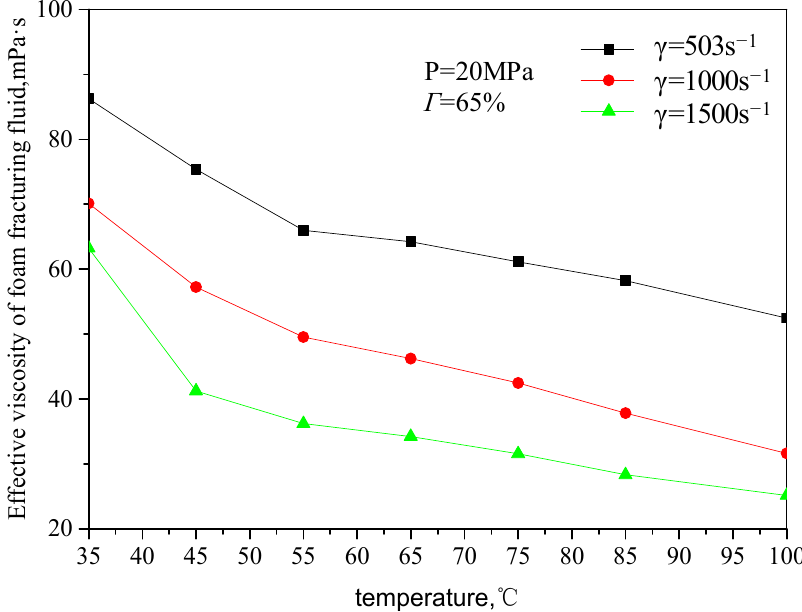
Figure 7. Variation curve of effective viscosity with temperature (foamed, foam mass is 65%).